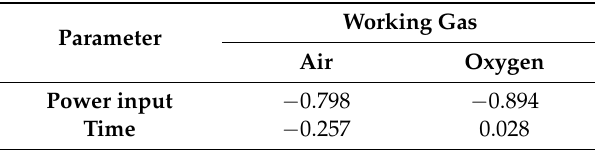
Table 4. Pearson’s